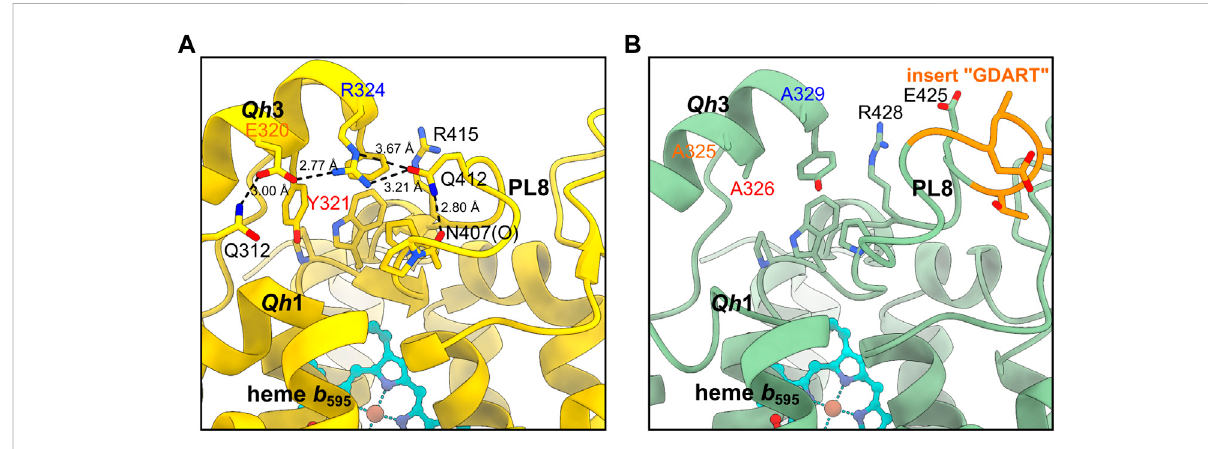
FIGURE 4 ComparisonoftheQh3-PL8regionin (A) Mtbd and (B) Cgbd .ThestabilizingresiduesE320,Y321andR324ofQ h 3in Mtbd (7NKZ)(Safarianetal., 2021) are replaced by alanines in Cgbd , presumably leading to a weaker interaction between Q h 3 and PL8.